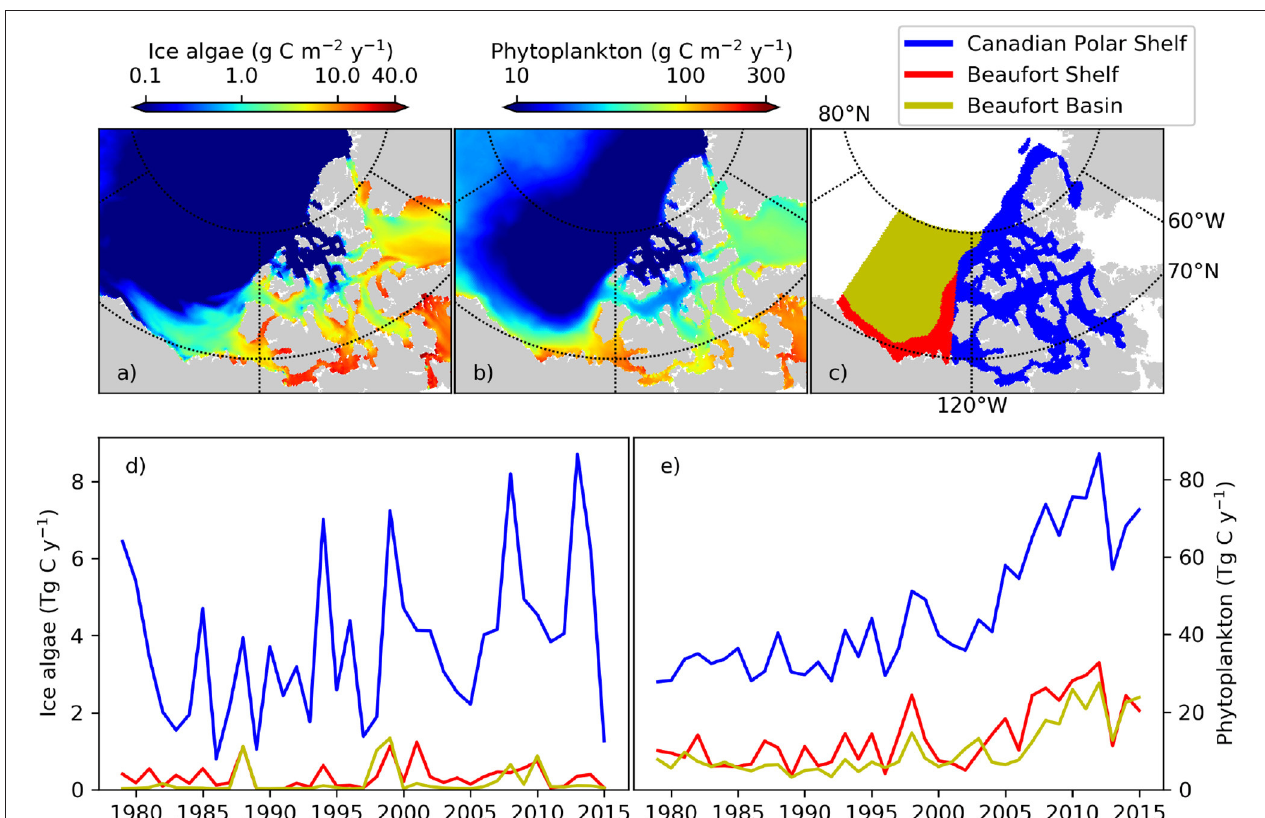
FIGURE 3 | (a) ice algal and (b) phytoplankton annual primary production in the Western Canadian Arctic averaged over the period 1979–2015 as simulated with the regional high resolution model NAA-CanOE-CSIB. (c) Areal definitions of three oceanographic subregions used for regional averaging. Time series of simulated (d) ice algal and (e) phytoplankton annual primary production integrated for each of the three